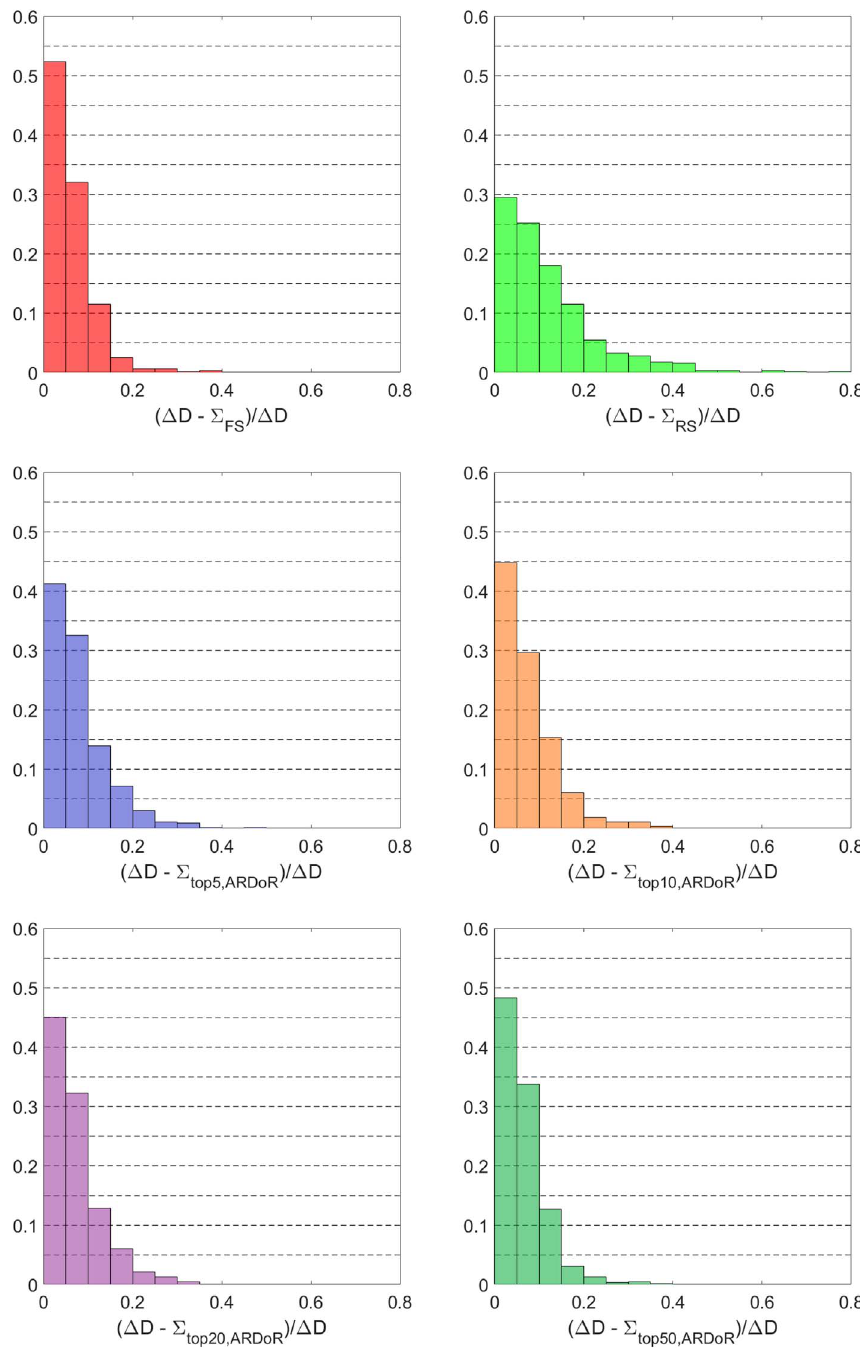
Fig. 4. Fractional histograms of the fractional deviation from the absolute change in dipole moment during a solar cycle, calculated summing ultimate AR contributions in the RS case + ARDoR values for ARs with the the top N highest ARDoR. ( N = N tot and N = 0 for the fi rst and second panels, respectively.) Colour codes are the same as in the previous